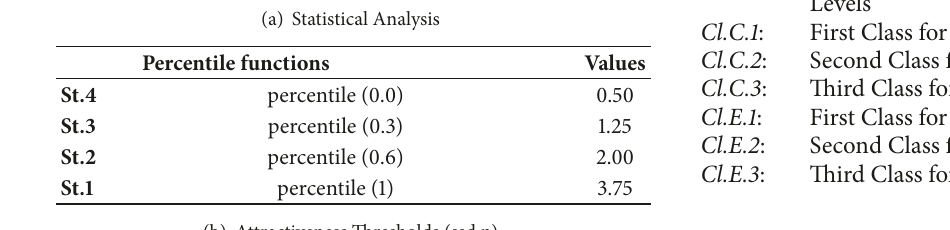
Table 13: MCSDA implementation for JLE: statistical analysis (a) and Thresholds of Attractiveness construction